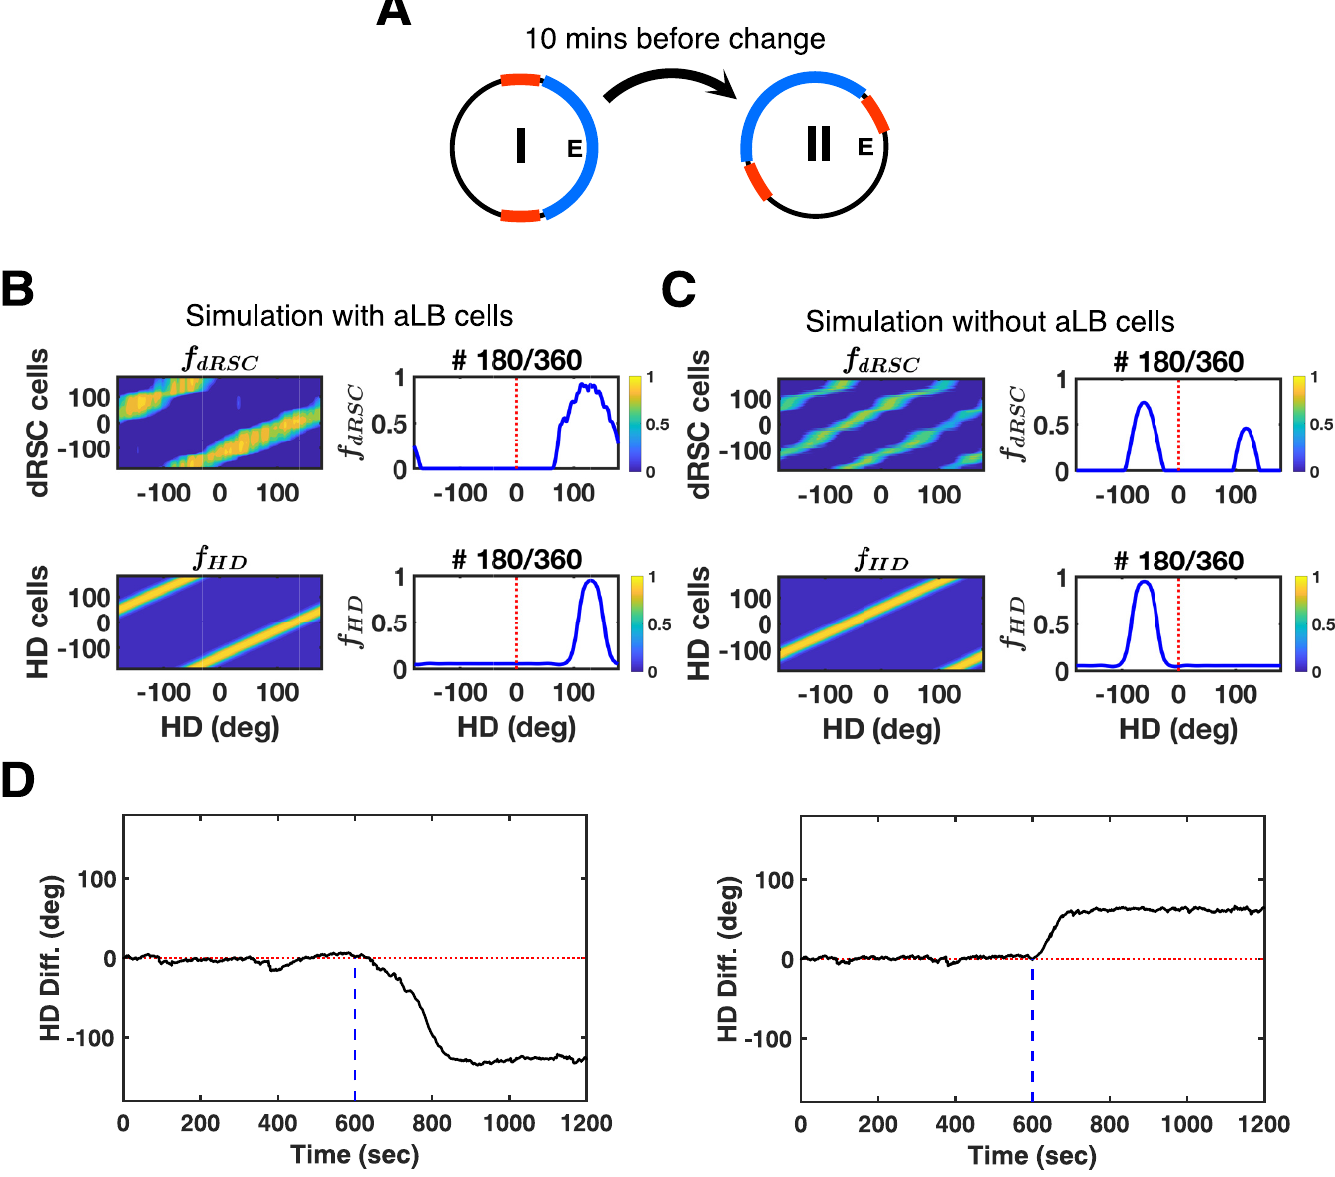
Fig 7. Testing scenery-based HD encoding at a sensory level with the two-environment scheme. (A) Sceneries in the first environment (Env. I) are all the same as Fig 2A, yet are rotated by 120˚ anticlockwise in the second environment (Env. II). Simulations are conducted within 20 minutes, assuming the agent explores each environment for 10 minutes. (B) Global representations of dRSC cells (top) and HD cells (bottom) tested on Env. II. Simulations are conducted via our two-stage model with aLB cells. (C) Global representations of dRSC cells (top) and HD cells (bottom) tested on Env. II. Simulations are conducted via the alternative model, shows an opposite direction of firing field drift from (B). This model does not contain aLB cells but rather a direct visual to dRSC connection (subject to classical Hebbian learning). (D) Simulations over the whole 20-minute learning time via our two-stage model with aLB cells (left) and the alternative model without aLB cells (right), showing opposite directions of HD drift. Abbreviations: HD: head direction; Diff.: difference; dRSC: dysgranular retrosplenial cortex; f : firing rate.